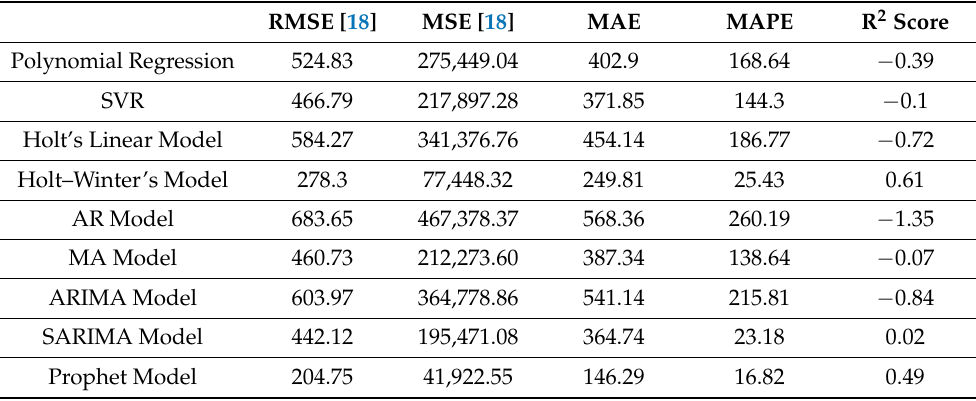
Table 10. Summarized description of all models’ performance